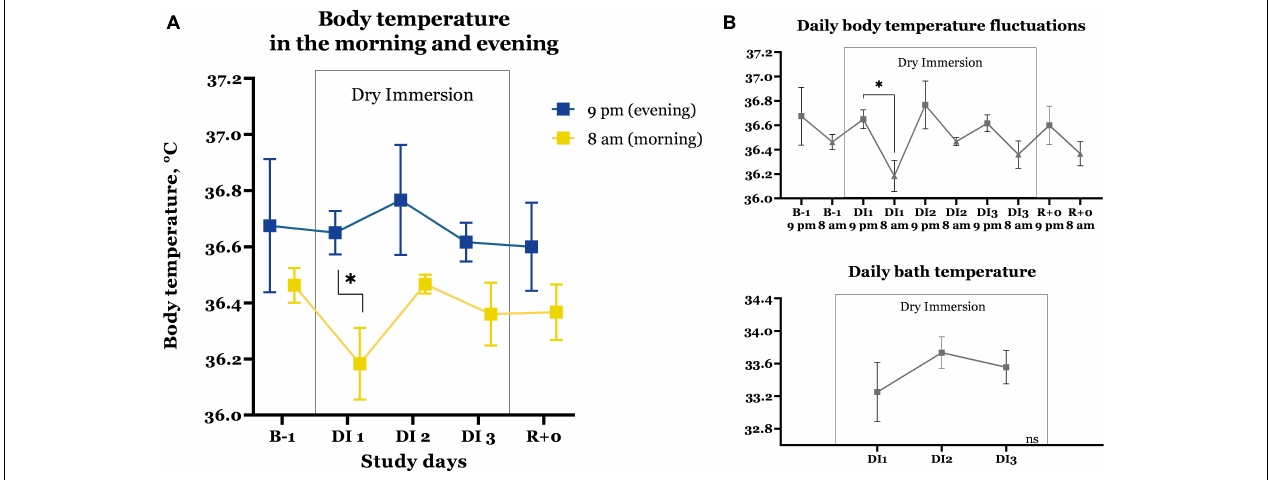
FIGURE 3 | Changes in body temperature of the subjects in the morning and in the evening (A) , daily fluctuations (B) , and water temperature in the immersion bath (C) . Mean ± SEM. * -significant difference, P < 0.05.